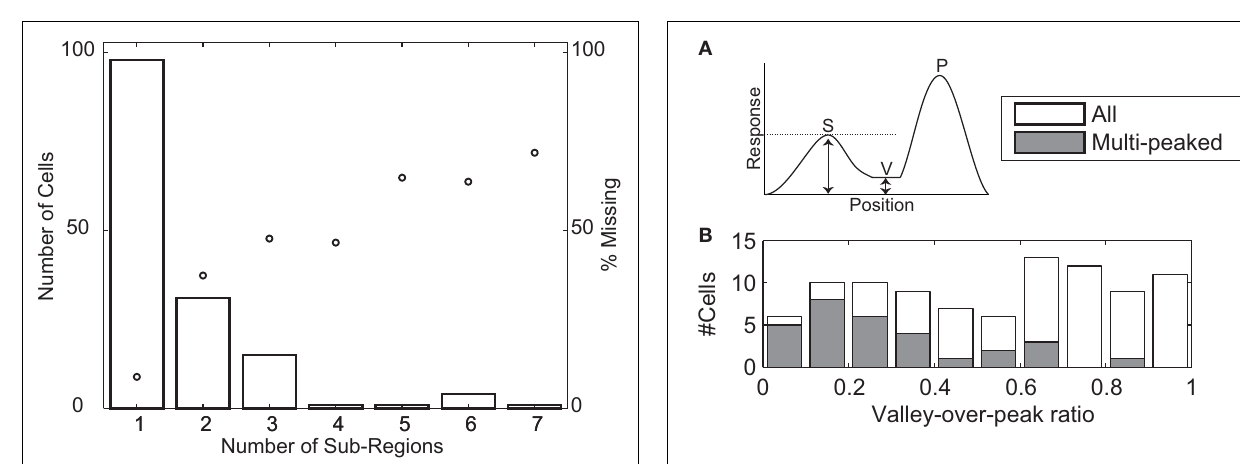
FIGURE 9 | Population overview of multi-peaked receptive fields. The histogram (using the vertical axis on the left) shows the number of cells whose receptive field is composed of a given number of sub-regions (horizontal axis).The circles (using the vertical axis on the right), represent the fraction of space inside the convex hull of the receptive field where cells with a given number of sub-regions (horizontal axis) fail to cross the response threshold.This shows that a considerable fraction of cells have receptive fields with multiple, spatially separate sub-regions with high sensitivity.